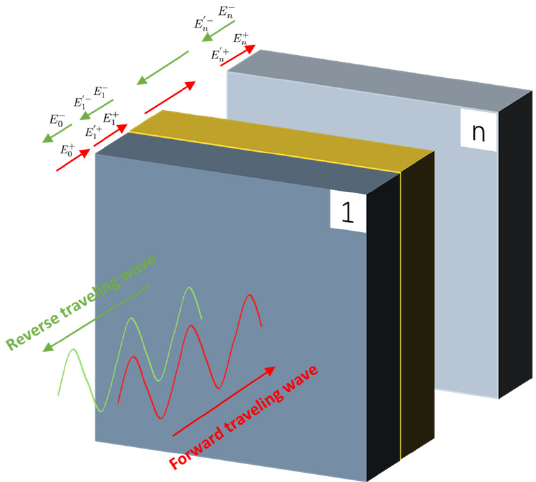
Figure A1. Schematic representation of multilayer structure. “1” and “n” correspond to the first and n-th layers respectively.